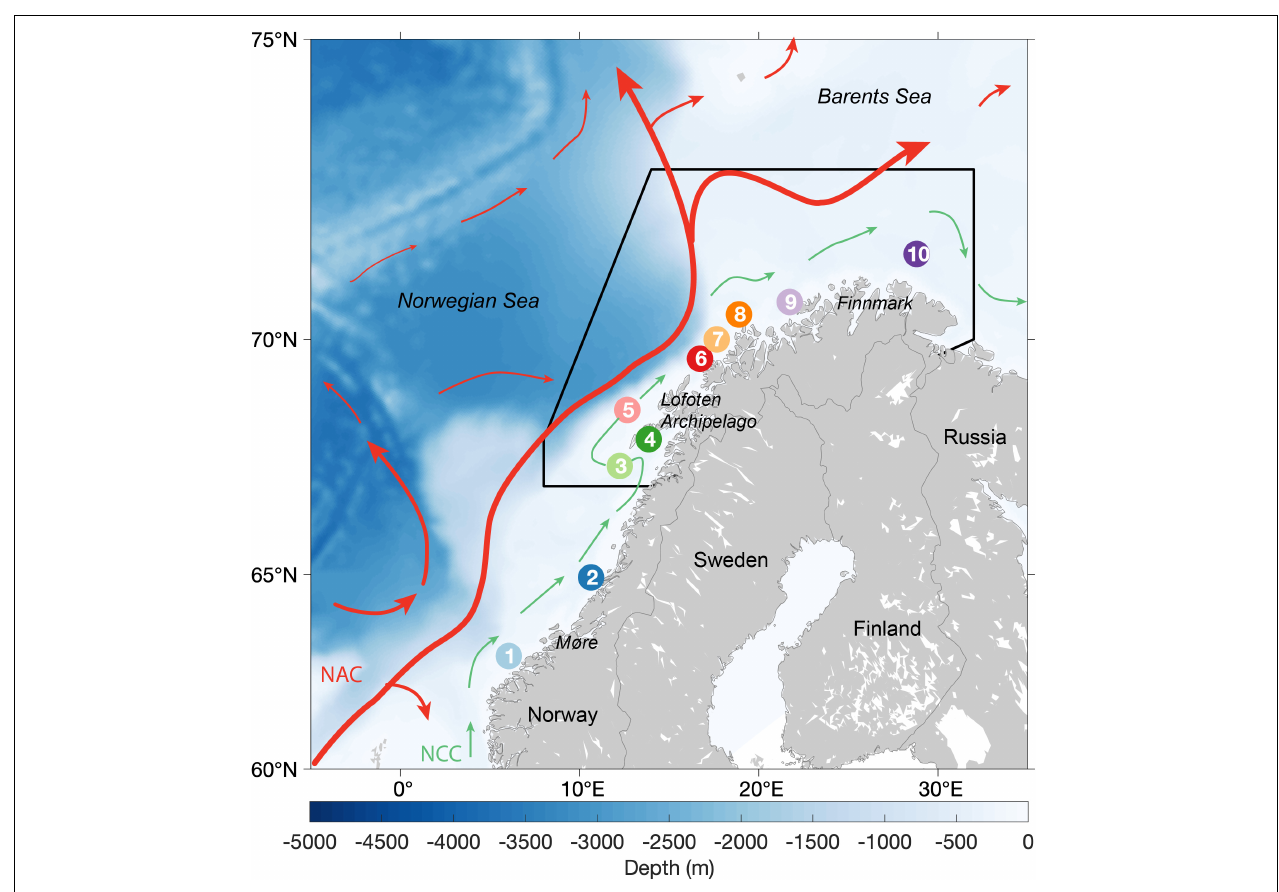
FIGURE 1 | Northeast Arctic cod spawning sites and origins of particle dispersal: 1- Møre, 2 - Vikna, 3 - Røst, 4- Lofoten, 5 - Moskenesgrunnen, 6 - Senja, 7 - Malangsgrunnen, 8 -Torsvåg, 9 - Breivikbotn and 10 - East Finnmark. The black polygon represents the area where 95% of the larvae (2000-2017) are located when they are 15 days post hatch. Main surface ocean currents pattern in the Norwegian and Barents Sea is illustrated by the arrows: Norwegian Coastal Current (NCC – green arrows) and Norwegian Atlantic Current (NAC - red arrows).